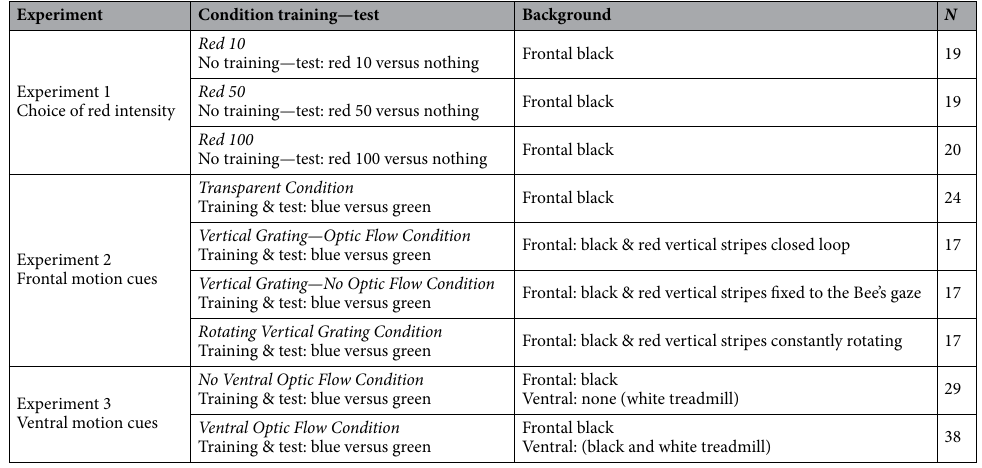
Table 1. Summary of the experimental conditions provided in Experiments 1 to 3. N: sample size of each